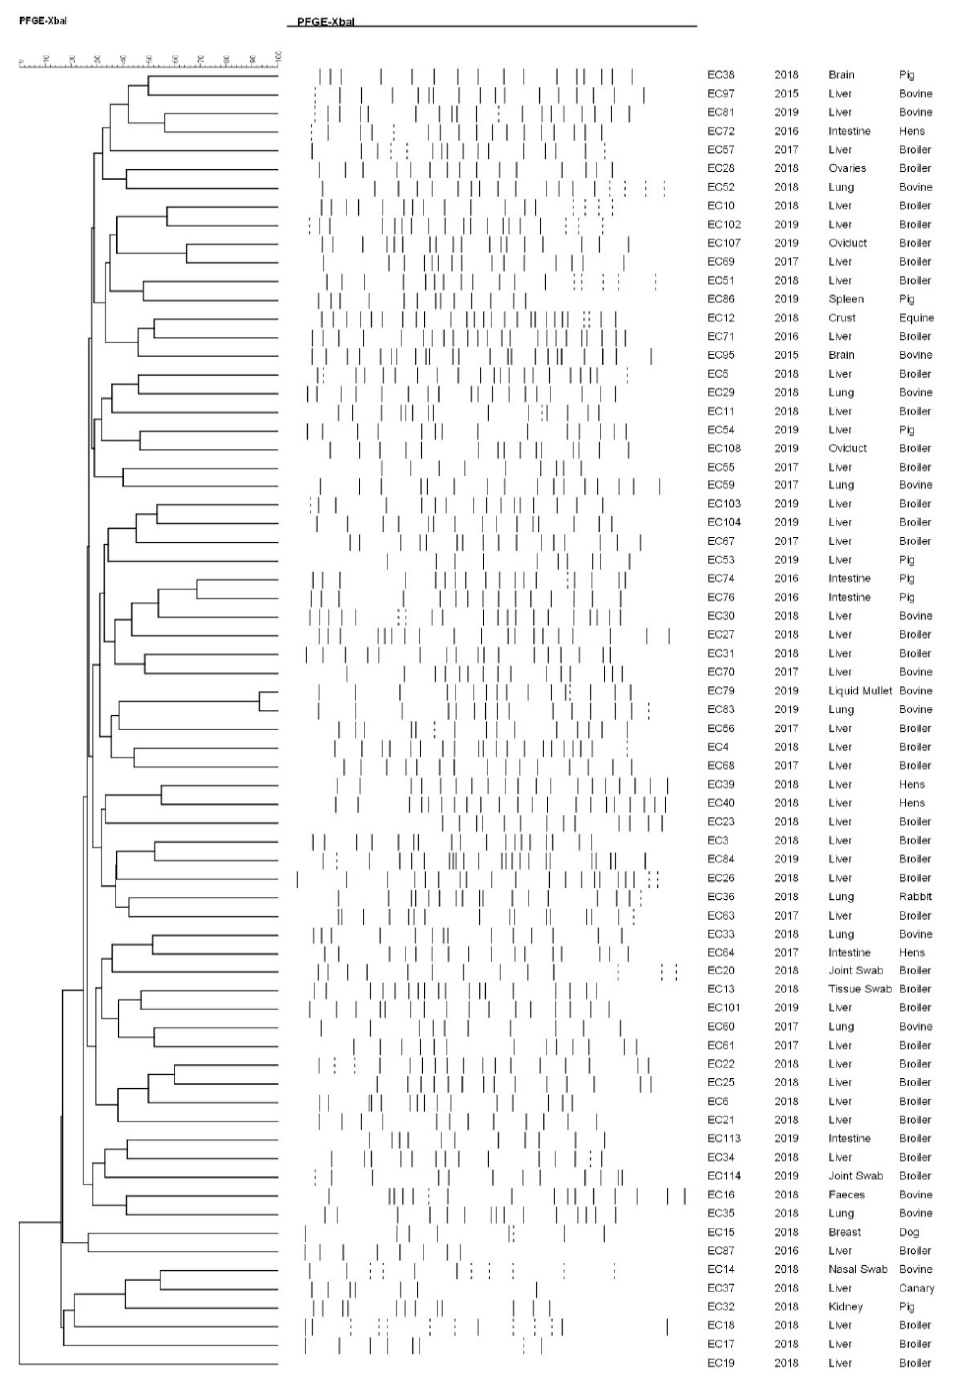
Figure 2. Escherichia coli phylogenetic three based on pulsed-field gel electrophoresis (PFGE) analysis.